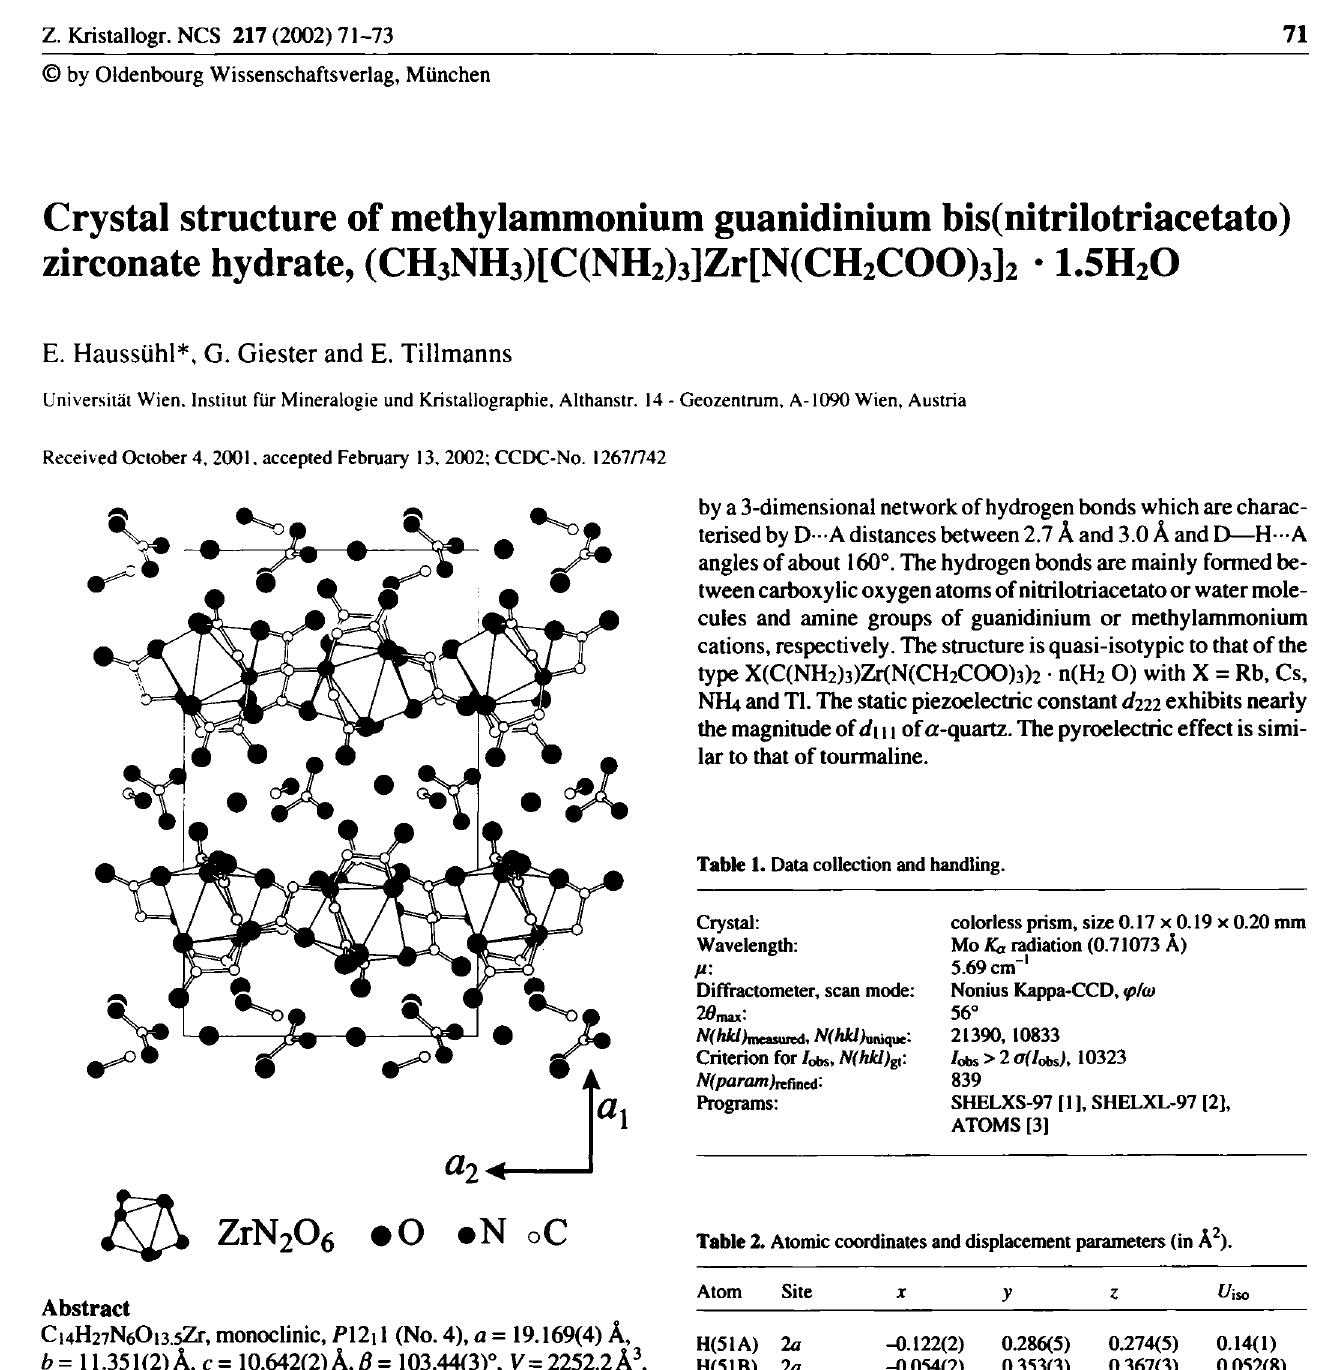
Table 2. Atomic coordinates and displacement parameters (in Â 2